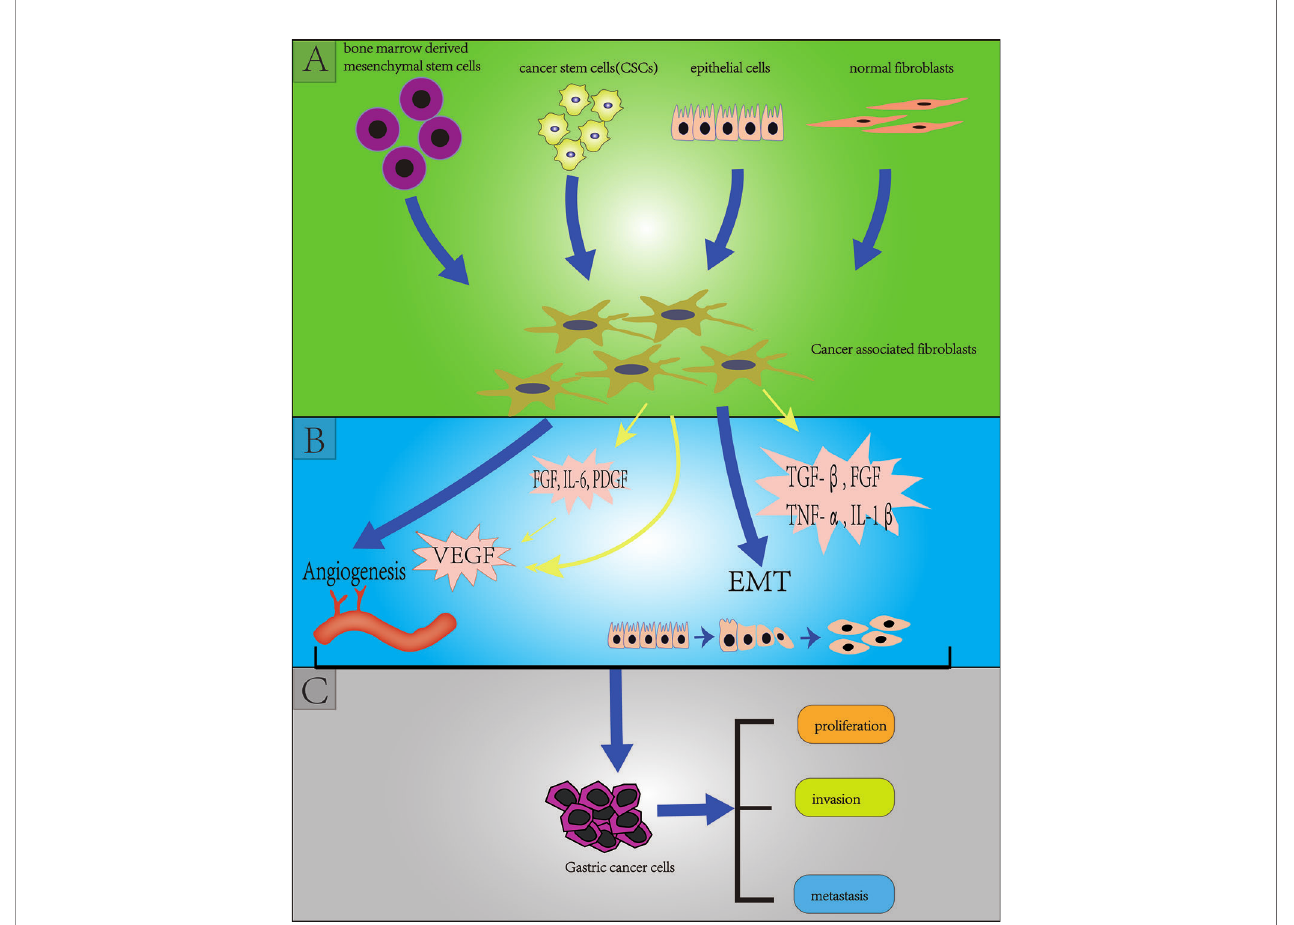
FIGURE 2 | Section (A) (green background) indicates the origins of cancer-associated fi broblasts (CAFs) including bone marrow derived mesenchymal stem cells, cancer stem cells, endothelial cells (through endothelial mesenchymal transition: EMT), normal fi broblasts; Section (B) (blue background) indicates the effect of CAFs on gastric cancer stem cells (GCSCs) including angiogenesis and EMT; Section (C) (grey background) indicates the effect of (GCSCs) on gastric cancer cells including proliferation, invasion and